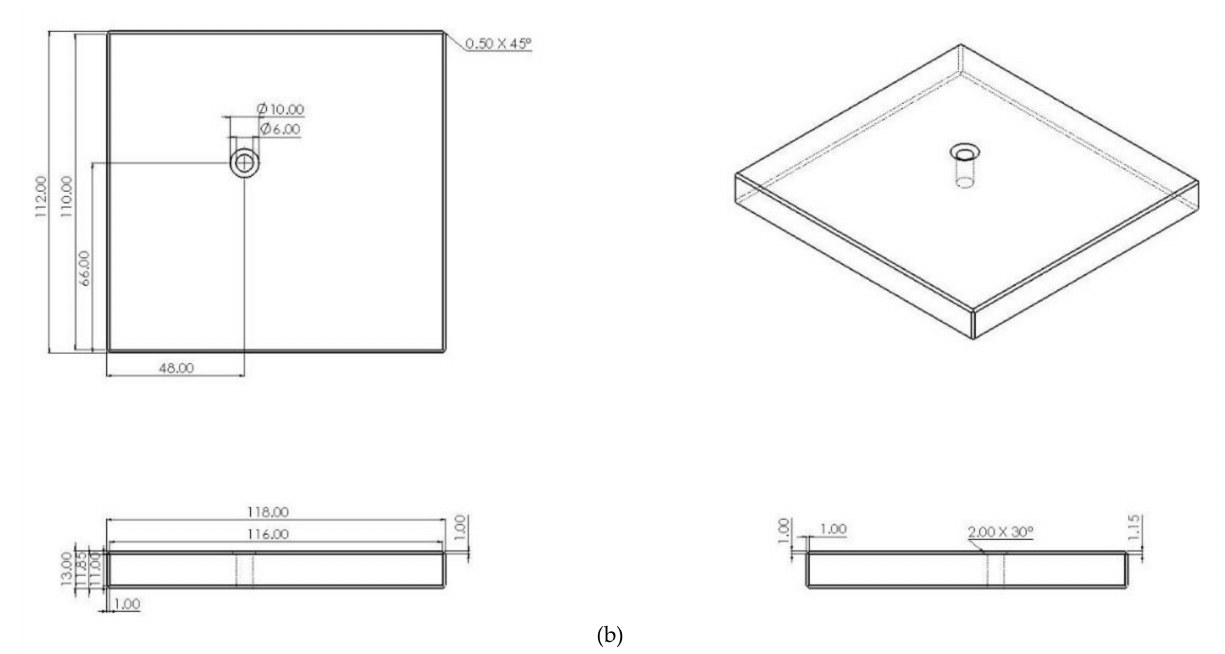
Figure A1. The detail dimensions of the filling model. (Unit: mm) ( a ) The Teflon block; ( b ) The resin pool.